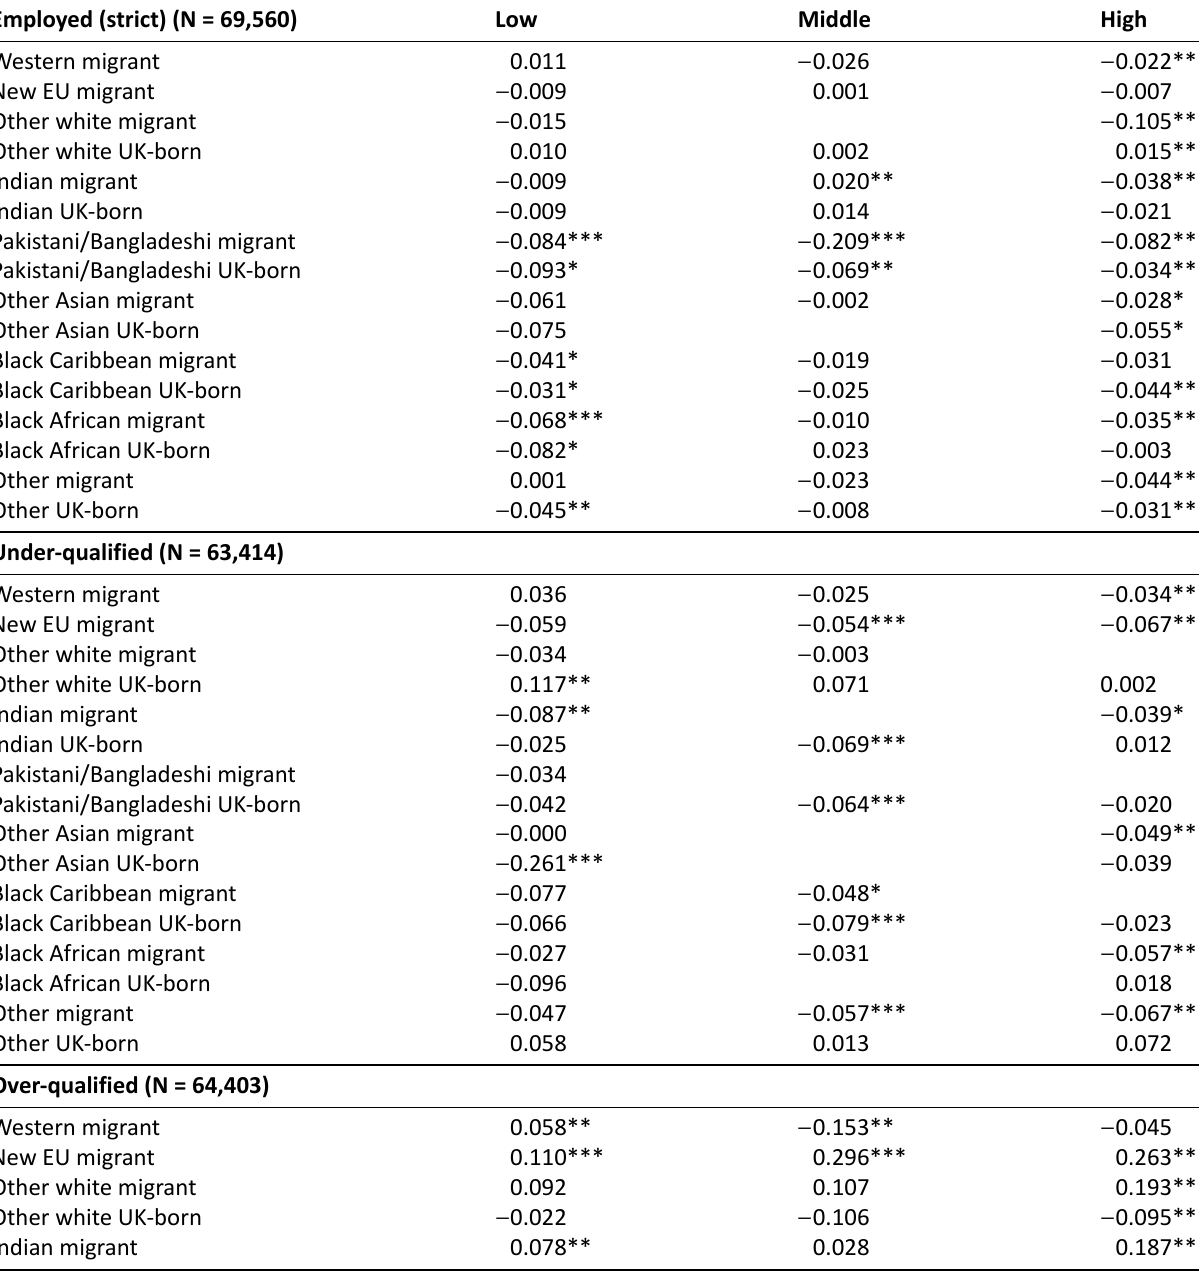
Table A9. Robustness tests for women: Binary logistic regression of being employed rather than unemployed, and under- and over-qualification using